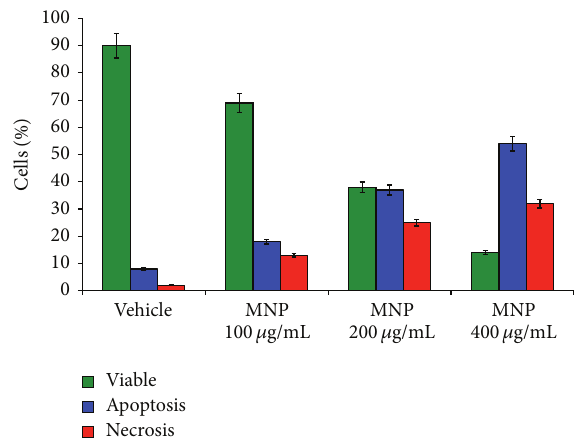
Figure 6: Flow cytometry analysis of untreated and treated MCF-7 cells with 𝛼 -Fe 2 O 3 for 24h stained with annexin V-FITC/propidium iodide (PI). Each bar represents the population of viable, apoptotic, and necrotic cells of three independent